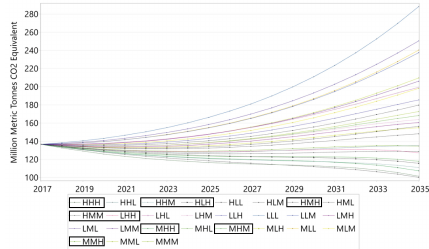
Figure 4. 100-Year GWP: Direct (Demand) plus